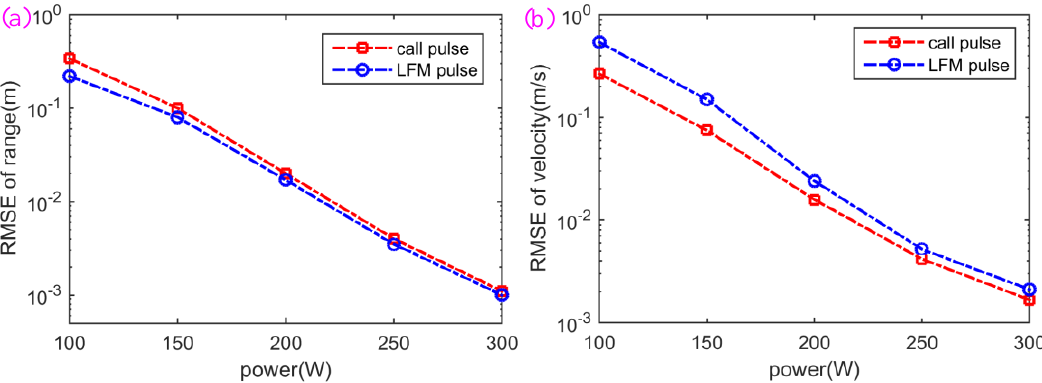
Figure 10. Output power comparison when the sperm whale call pulse and LFM pulse are used to serve as the sonar signal waveforms for range measurement of the underwater target. ( a ) RMSE of range, ( b ) RMSE of velocity.